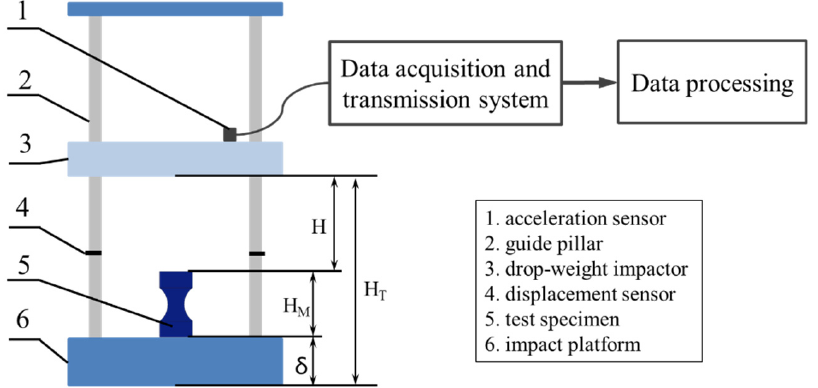
Figure 7. Schematic diagram of the dynamic compression tester.